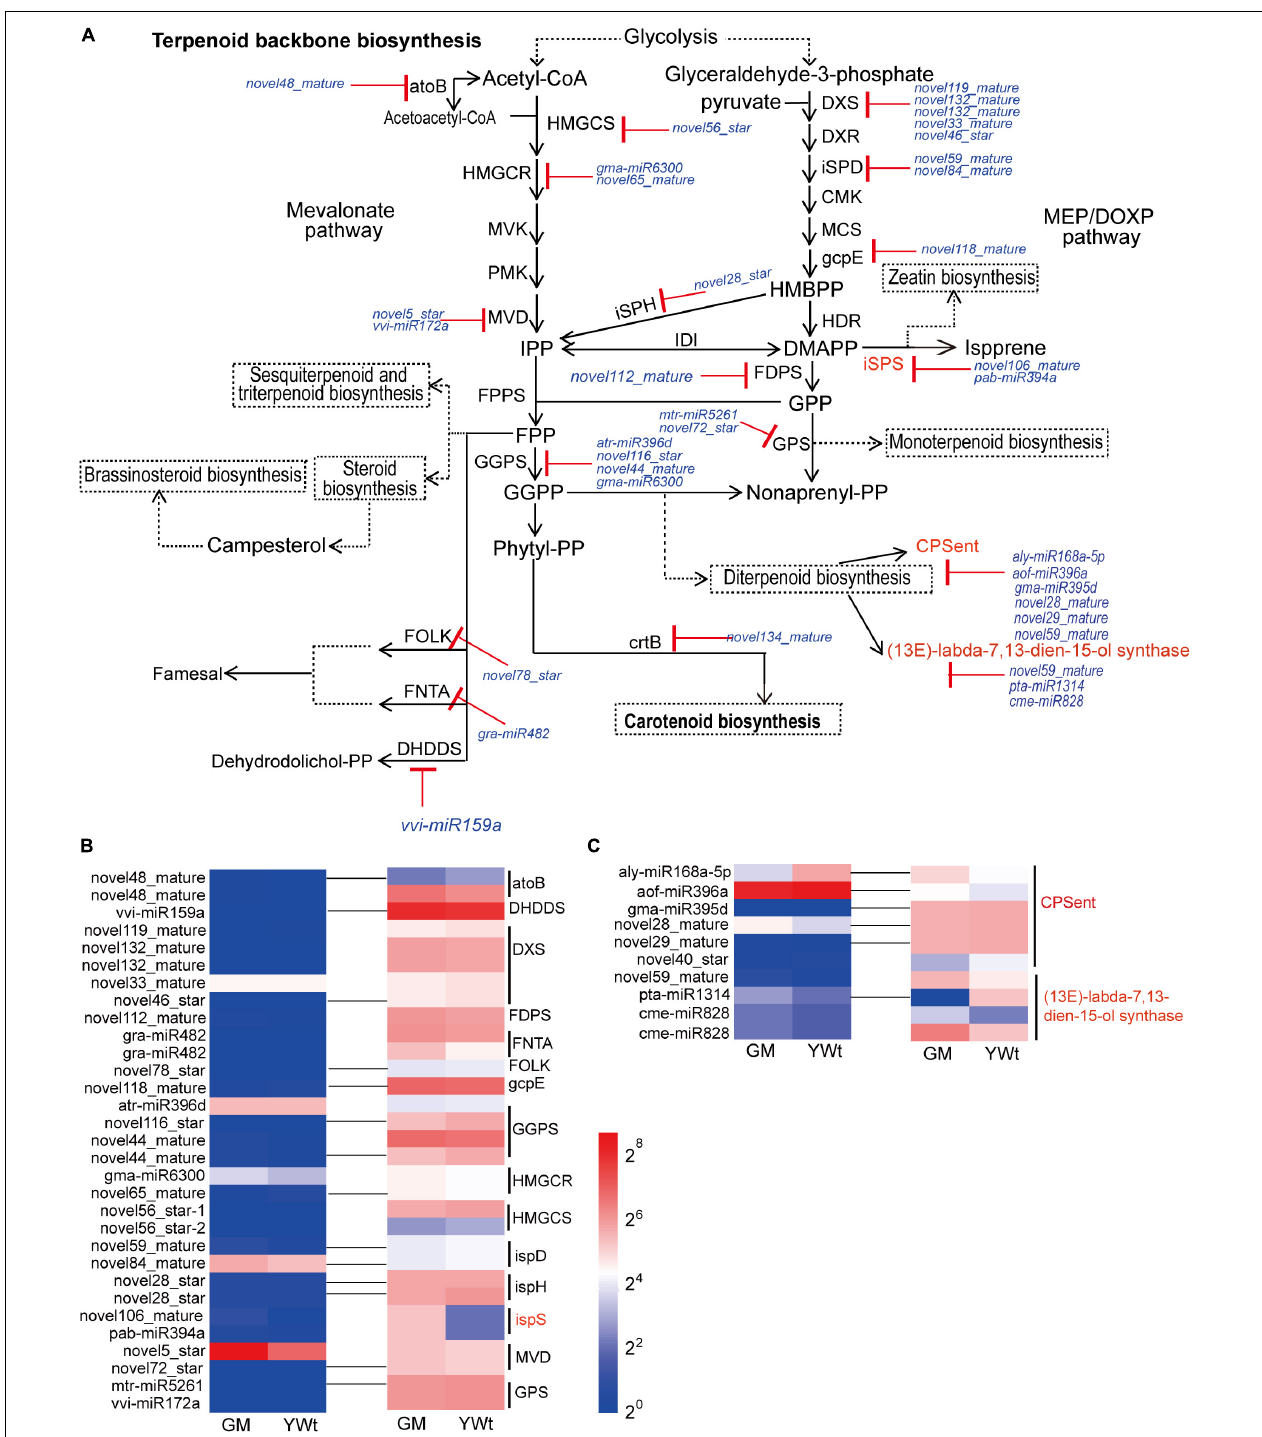
FIGURE 7 | Analysis of miRNA targets involved in terpenoid and polyketide biosynthesis (TPB). (A) miRNA targets involved in TPB. miRNA cleavage is indicated by solid lines with red “T” arrows. miRNA targets involved in TPB (B) and diterpenoid biosynthesis (C) . The pseudo-color bar at the bottom of the middle represents the fragments per kilobase of exon per million (FPKM) value, GM, evergreen mutant; YWt, yellowish-brown needles in winter. The abbreviation of each gene/metabolite is as follows: atoB , acetyl-CoA acetyltransferase; CMK , 4-(cytidine 5-diphospho)-2-C-methyl- D -erythritol kinase; CPSent , ent-copalyl diphosphate synthase; crtB , 15- cis -phytoene synthase; DHDDS , ditrans,polycis-polyprenyl diphosphate synthase; DMAPP , dimethylallyl diphosphate; DXR , 1-deoxy- D -xylulose 5-phosphate reductoisomerase; DXS , 1-deoxy- D -xylulose-5-phosphate synthase; FDPS , farnesyl diphosphate synthase; FNTA , protein farnesyltransferase/geranylgeranyltransferase type-1 subunit alpha; FOLK , farnesol kinase; FPP , farnesyl diphosphate; FPPS , farnesyl pyrophosphate synthase;